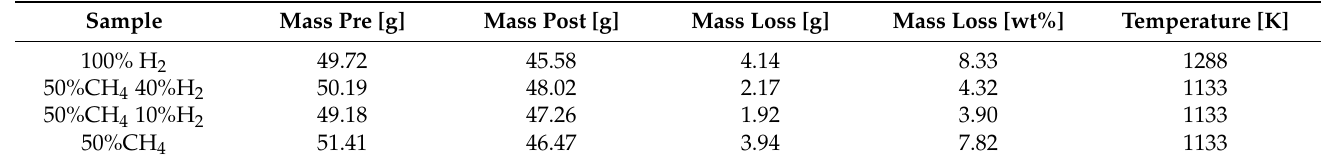
Table 4. Mass data and mass losses in reduction of calcined PMMN ore.